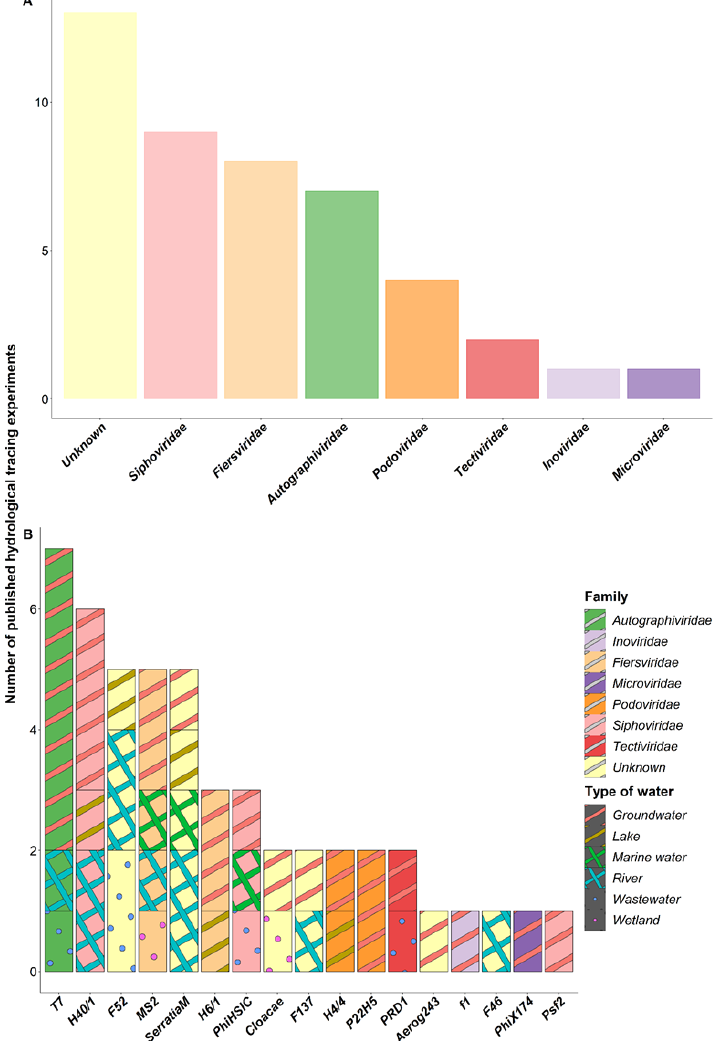
Figure 2. Distribution of bacteriophages commonly used in hydrological tracing experiments, classified according to ( A ) the bacteriophage families and ( B ) the bacteriophage species. Bacteriophage families are distinguishable by the background colours of the bar chart, and the type of water studied is represented by the coloured pattern textures. Unknown = bacteriophage strains (Cloacae phage, Serratia phage, Aerog243 phage, F137, F52, and F46) for which the families are not known. The viral taxonomy built by the International Committee on Taxonomy of Viruses (ICTV) has recently been updated based on genetic similarities between bacteriophages, thus involving a reclassification of the entire order Caudovirales . For the bacteriophages of this review whose strain and family names have been changed, both the old and new names are mentioned. However, it should be noted that only the names employed in the articles have been retained for convenience. The detailed characteristics of all bacteriophages used as hydrological tracers are summarised in Table 1. Briefly, most of them have a DNA genome with a head-tail struc- ture, except PRD1, phiX174 and MS2, which all have a single capsid. In addition, MS2 is the only one with an RNA genome. Of all the bacteriophages used in the tracing experi- ments, MS2, T7, PRD1 and phiX174 are the best known and the most widely described in